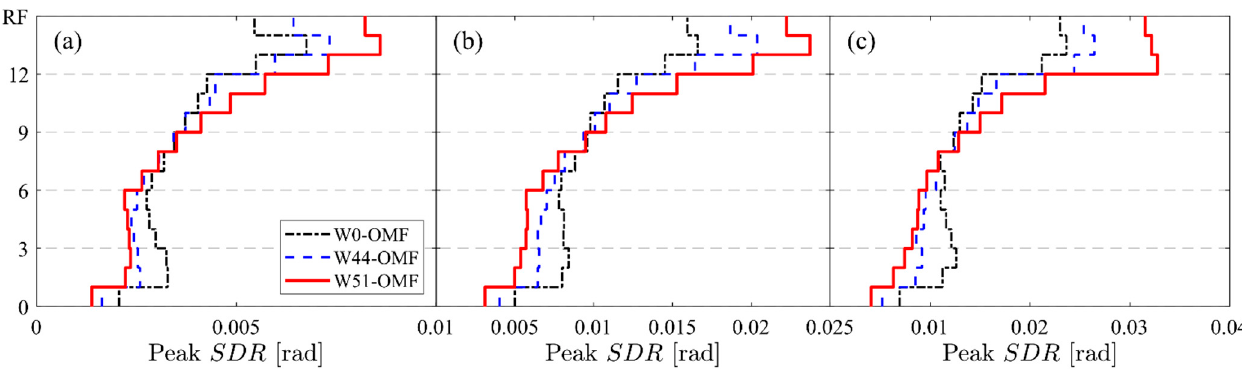
Figure 9. Peak story drift ratio ( 𝑆𝐷𝑅 ) of 15-story steel OMFs: ( a ) service level earthquake (SLE); ( b ) design-based earthquake (DBE); ( c ) maximum considered earthquake (MCE).